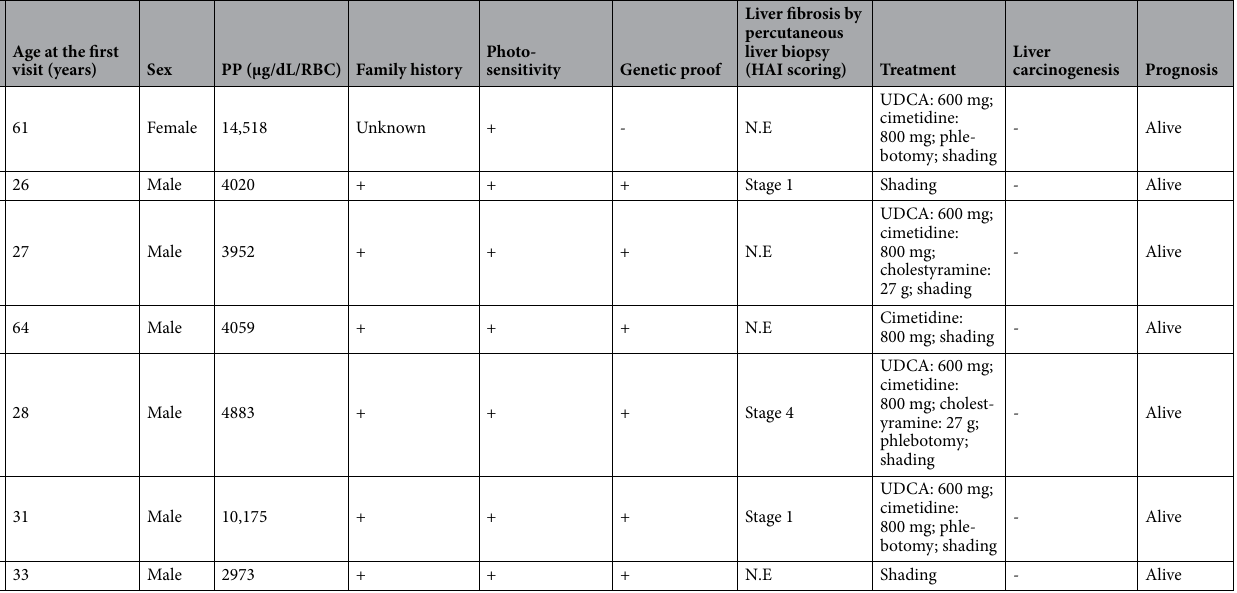
Table 1. Patient background. PP protoporphyrin, UDCA ursodeoxycholic acid, HAI histological activity index.